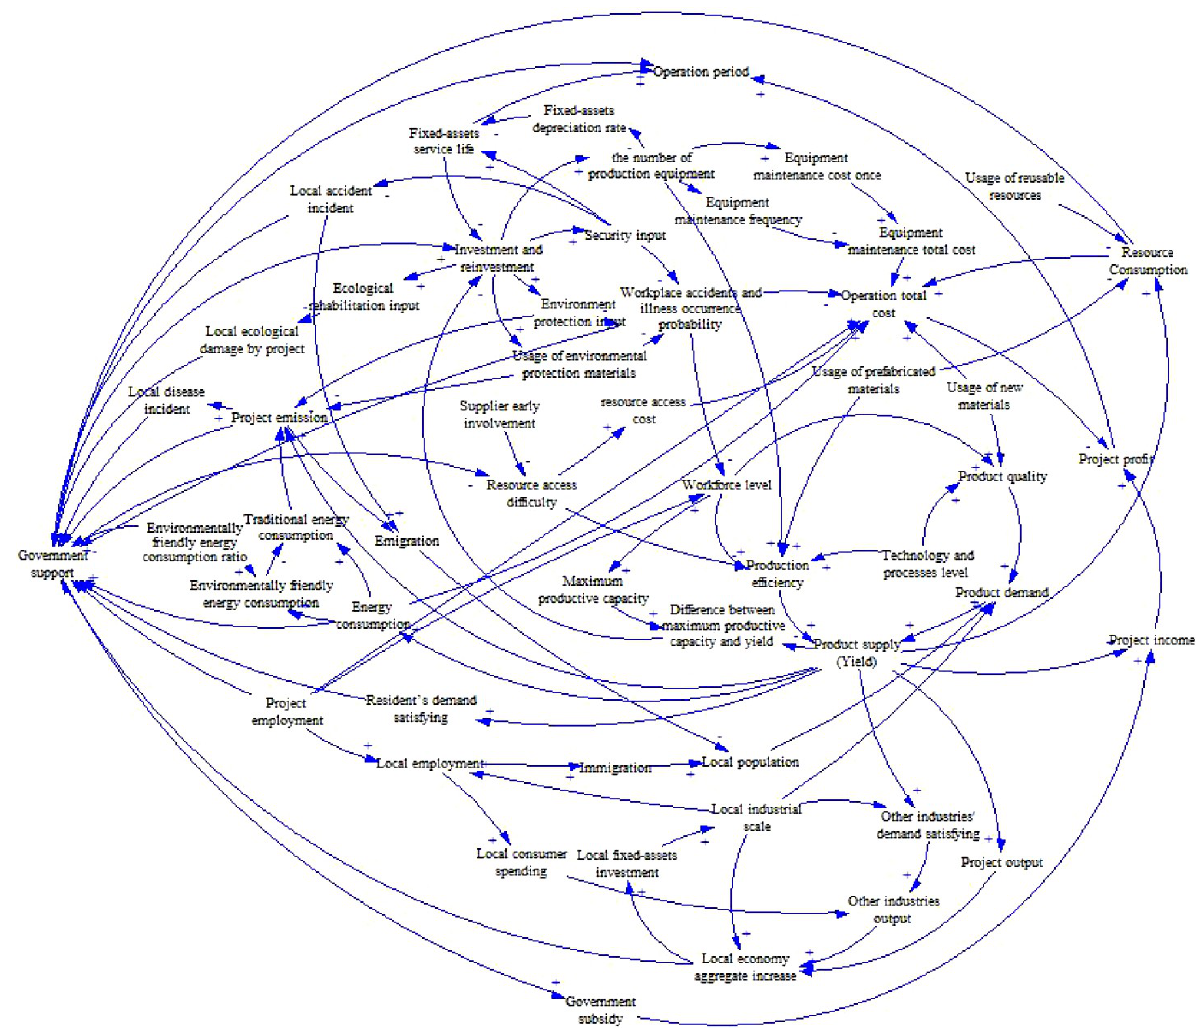
Figure 5. The integrity causal loop diagrams of the